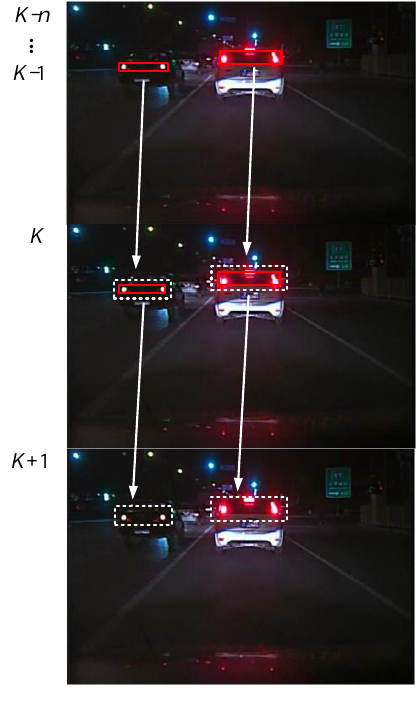
Figure 6. Illustration of the tracking-based detection